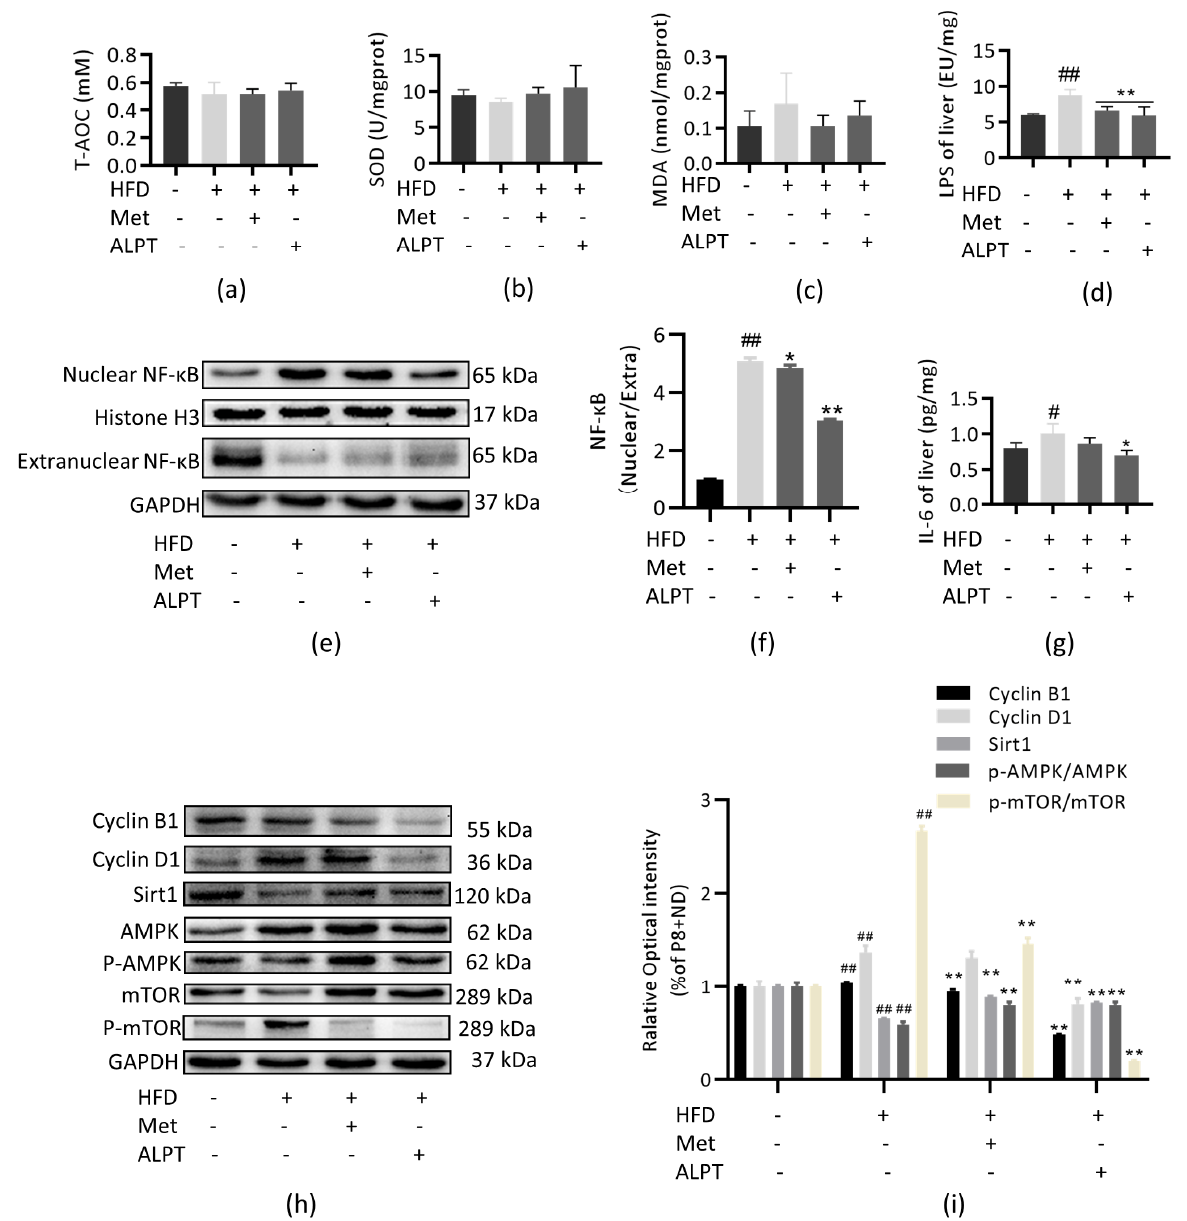
Figure 3. ALPT delays liver aging by anti-inflammatory and metabolic regulation. ( a – c ) Total antioxidant capacity (T-AOC), superoxide dismutase (SOD) and malondialdehyde (MDA) content assay, n = 5; ( d , g ) lipopolysaccharide (LPS) and interleukin-6 (IL-6) content assay, n = 5; ( e , f ) western blotting detection of nuclear transcription factor-kappa B (NF- κ B), n = 3; ( h , i ) western blotting detection of G2/M-specific cyclin B1 (Cyclin B1), G1/S-specific cyclin D1 (Cyclin D1), Sirtuin 1 (Sirt1), Adenosine 5 (cid:48) -monophosphate (AMP)-activated protein kinase (AMPK), mammalian target of rapamycin (mTOR), phospho-adenosine 5 (cid:48) -monophosphate (AMP)-activated protein kinase (p- AMPK) and phospho-mammalian target of rapamycin (p-mTOR), n = 3. # represents compared with P8+ND group, p < 0.05, ## represents compared with P8+ND group, p < 0.01, * represents compared with P8+HFD group, p < 0.05, ** represents compared with P8+HFD group, p <